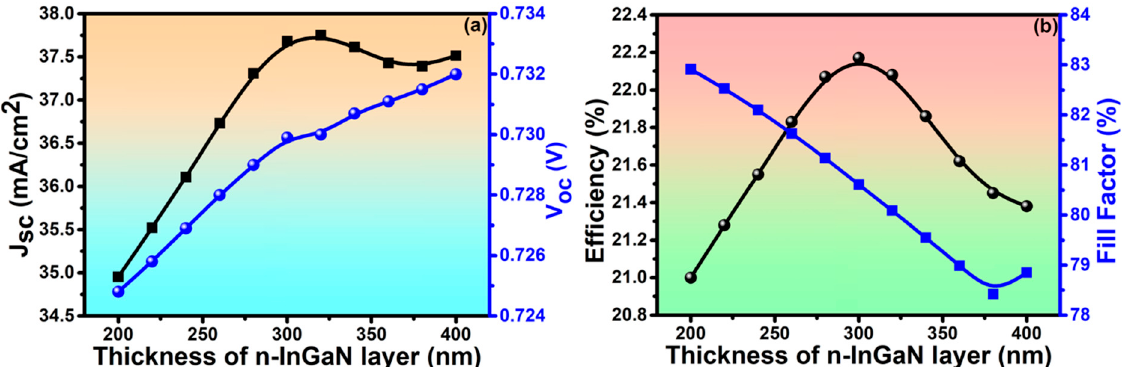
Figure 4. Impact of the thickness of the n-InGaN region on ( a ) short-circuit current density and open-circuit voltage, and ( b ) efficiency and fill factor.